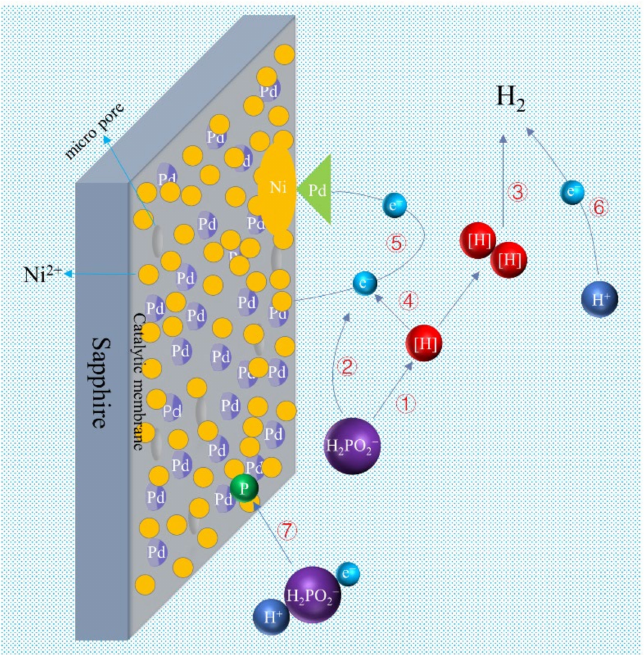
Figure 3. Deposition process and mechanism in the electroless plating solution. Figure 2d exhibits the surface morphology of the sapphire after pre-plating for 25